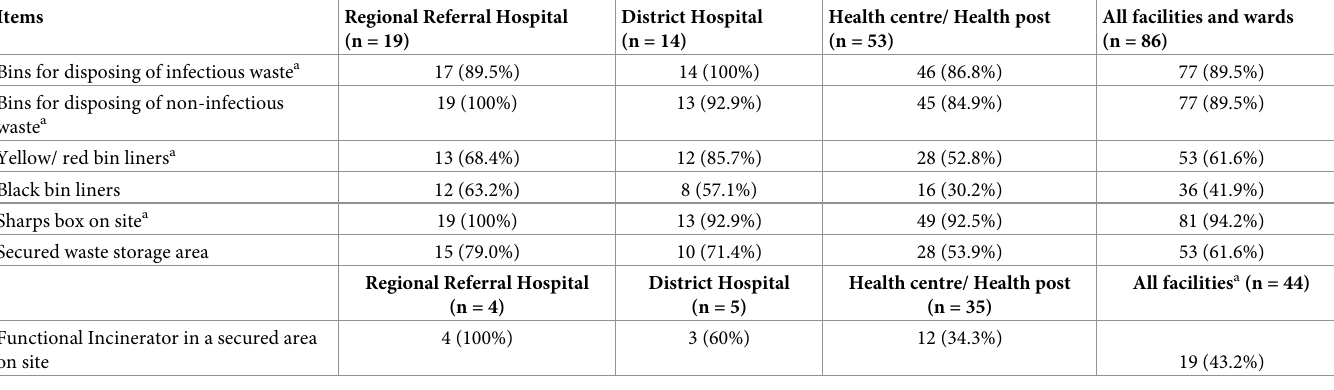
Table 5. Presence of various waste management items at the health facility or ward